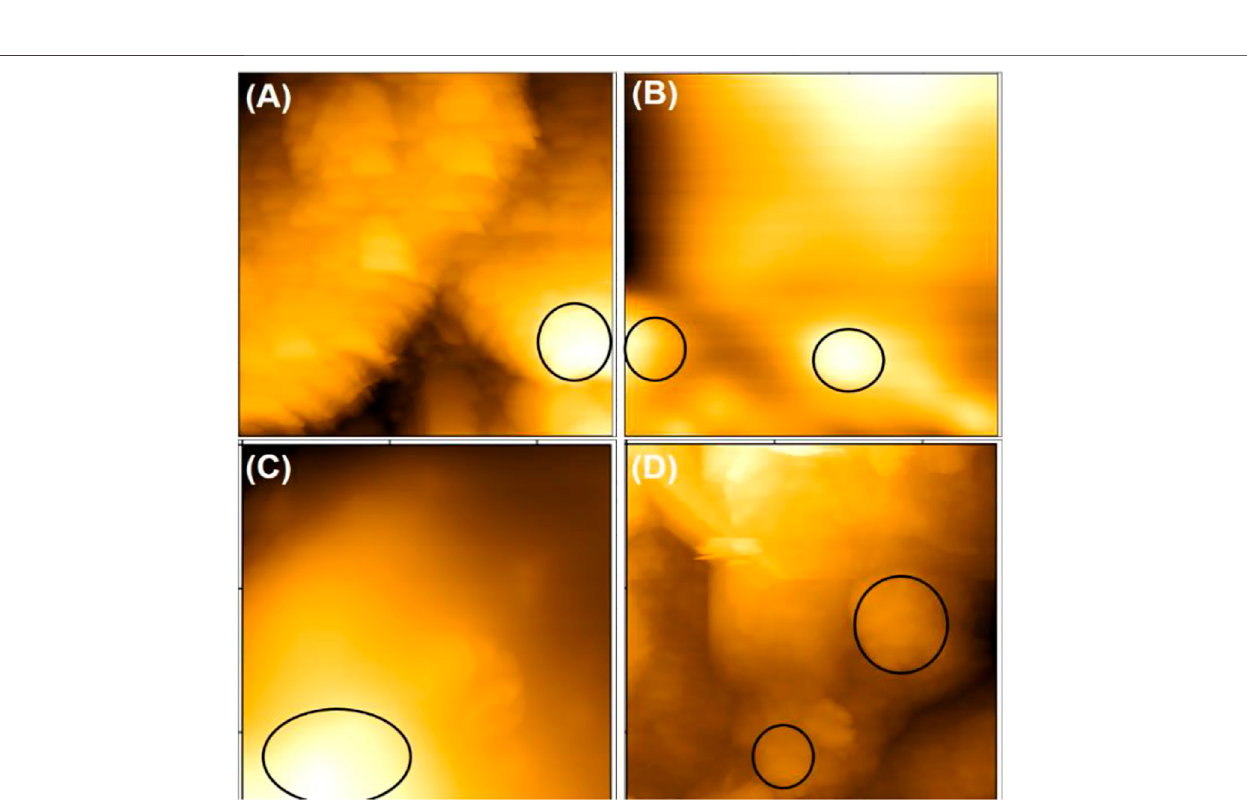
used as a working electrode. Silver-silver chloride (Ag/AgCl) electrode saturated in Potassium Chloride (KCl) was used as a reference electrode. Platinum wire was used as a counter for cyclic voltammetry characterization. Electrolytes were taken in the cell. All three electrodes (modi fi ed electrode that acts as working electrode, reference electrode, and counter electrode) were dipped in the cell. A glassy carbon electrode (GCE) was